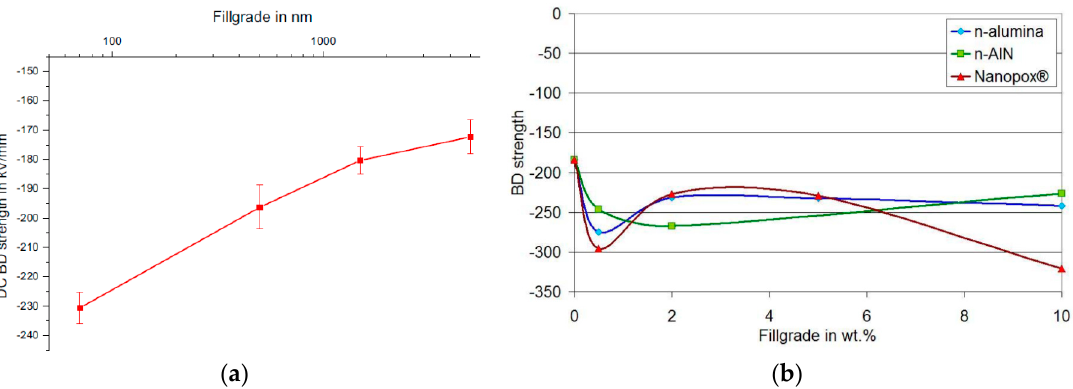
Figure 32. ( a ) Short term DC breakdown strength for BN/epoxy resin composites as a function of filler size (© 2016 IEEE. Reprinted, with permission, from [30]) and ( b ) Weibull scale parameter, which shows the voltage for 63.2% failure probability of samples with two components (epoxy resin and nanofillers) (© 2016 IEEE. Reprinted, with permission, from [157]).